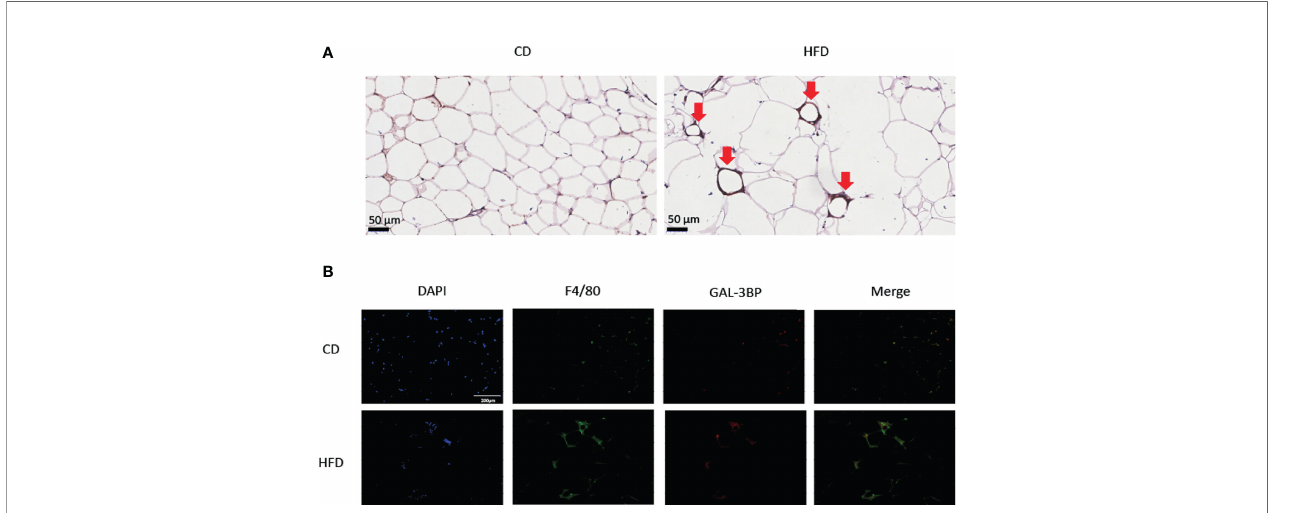
FIGURE 2 | The expression of GAL-3BP in the Visceral Adipose Tissues. (A) Representative images of F4/80 staining in VAT after HFD or CD exposure. 100 × (B) Representative images of immuno fl uorescent staining for F4/80 and GAL-3BP adducts. 100 ×. n =